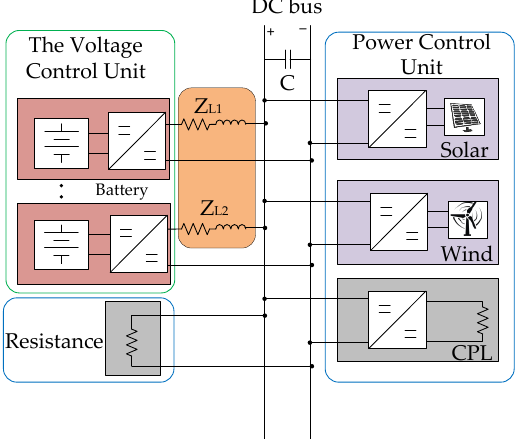
Figure 1. Typical configuration of an island direct current (DC) micro grid.